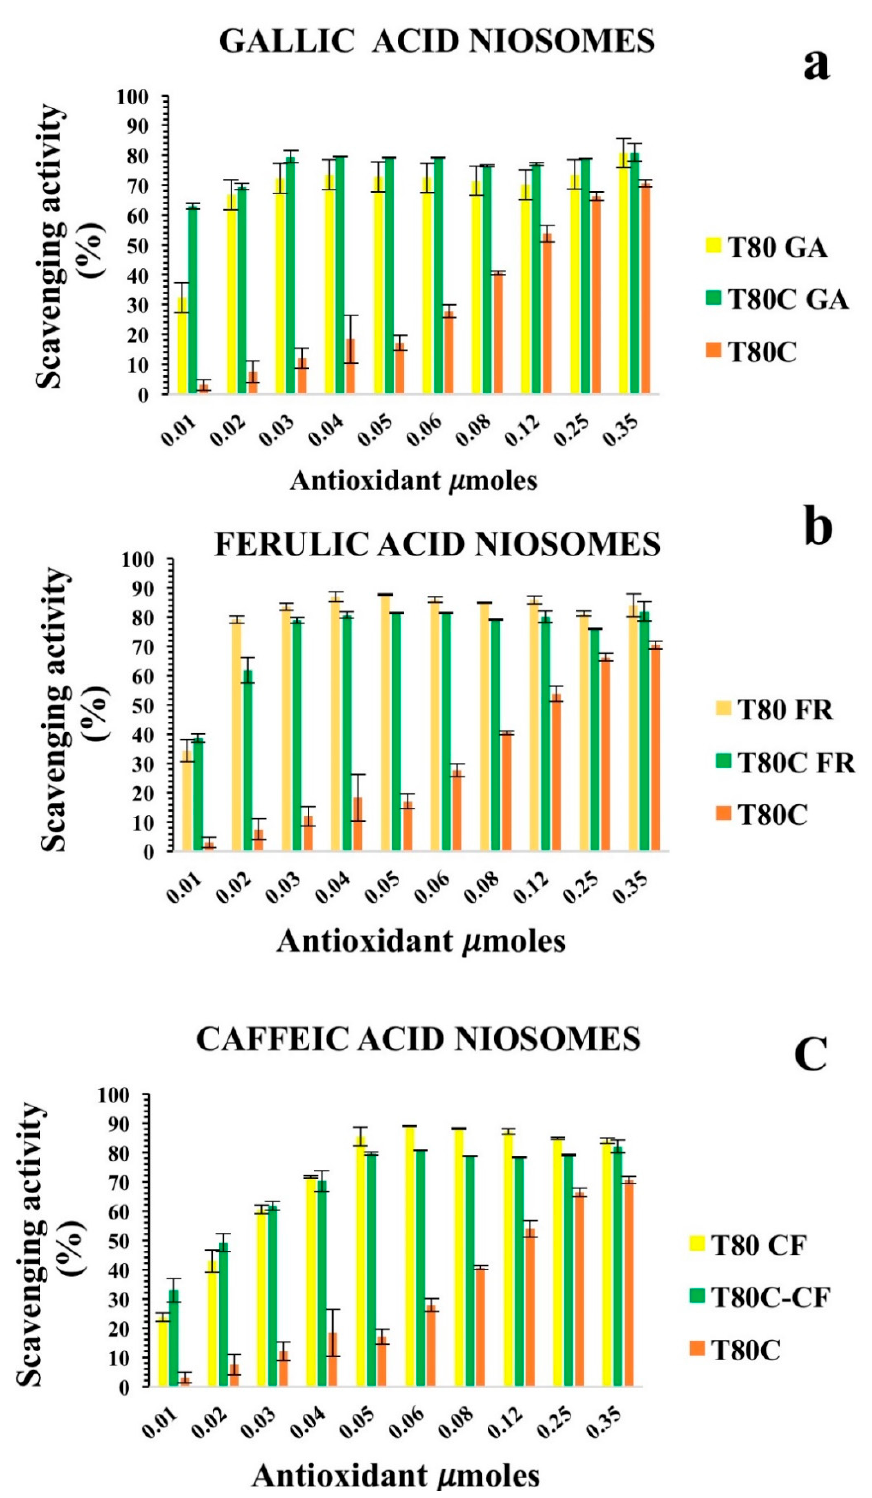
Figure 5. Antioxidant activity of empty (yellow) and CUR-loaded (orange) T80-GA ( a ), T80-FR ( b ), and T80-CF; ( c ) against ABTS • expressed as percentage of radical scavenging activity versus antioxi- dant µ moles grafted onto niosomes’ surfaces. Results represent the mean ± S.D. of three independent experiments performed with triplicate